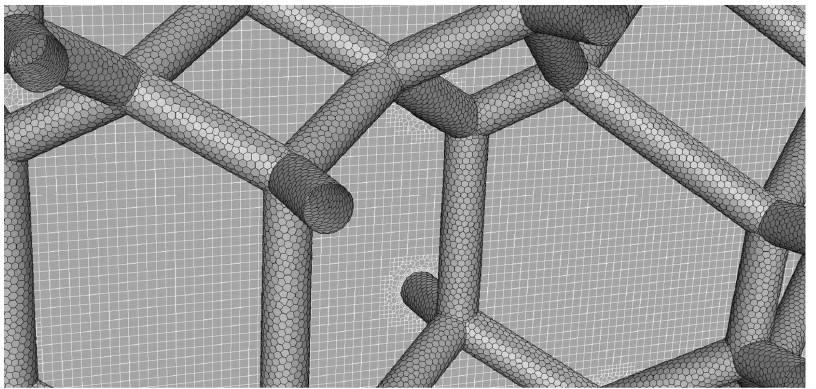
Figure 5. The Voronoi foam grid (G4).